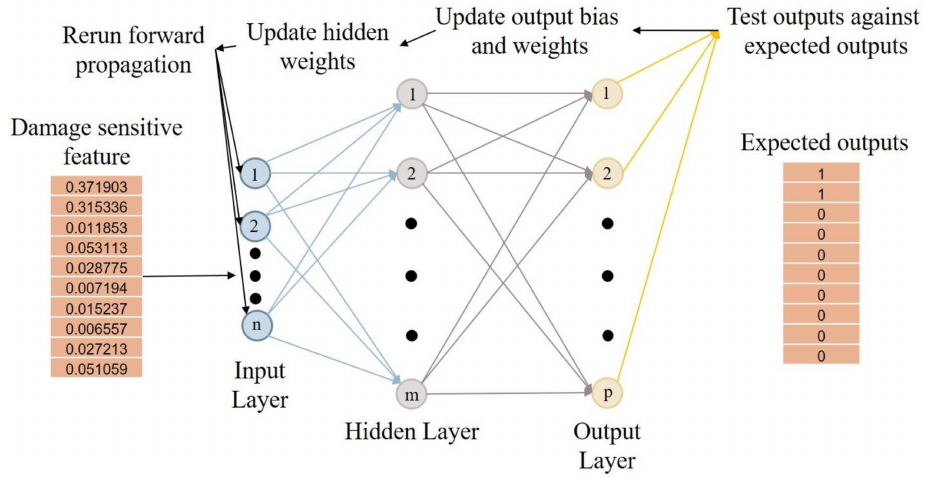
Figure 2. Artificial Neural Network